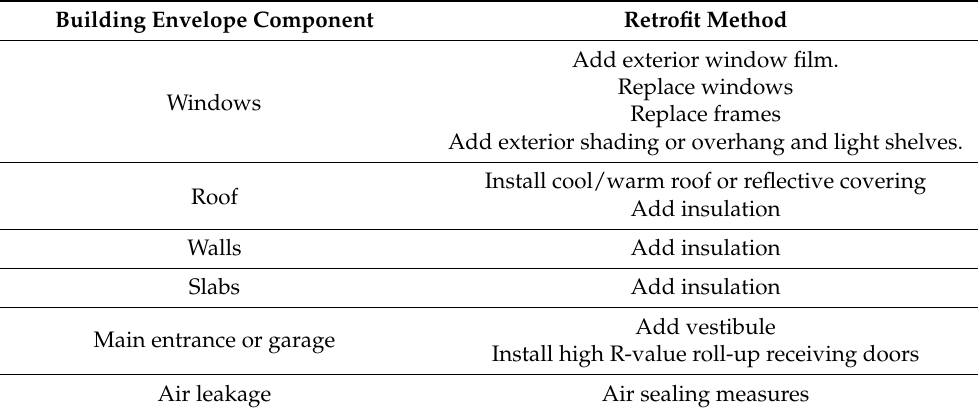
Table 4. Building envelope energy retrofit methods reviewed in Department of Energy (DOE) guides (adopted from